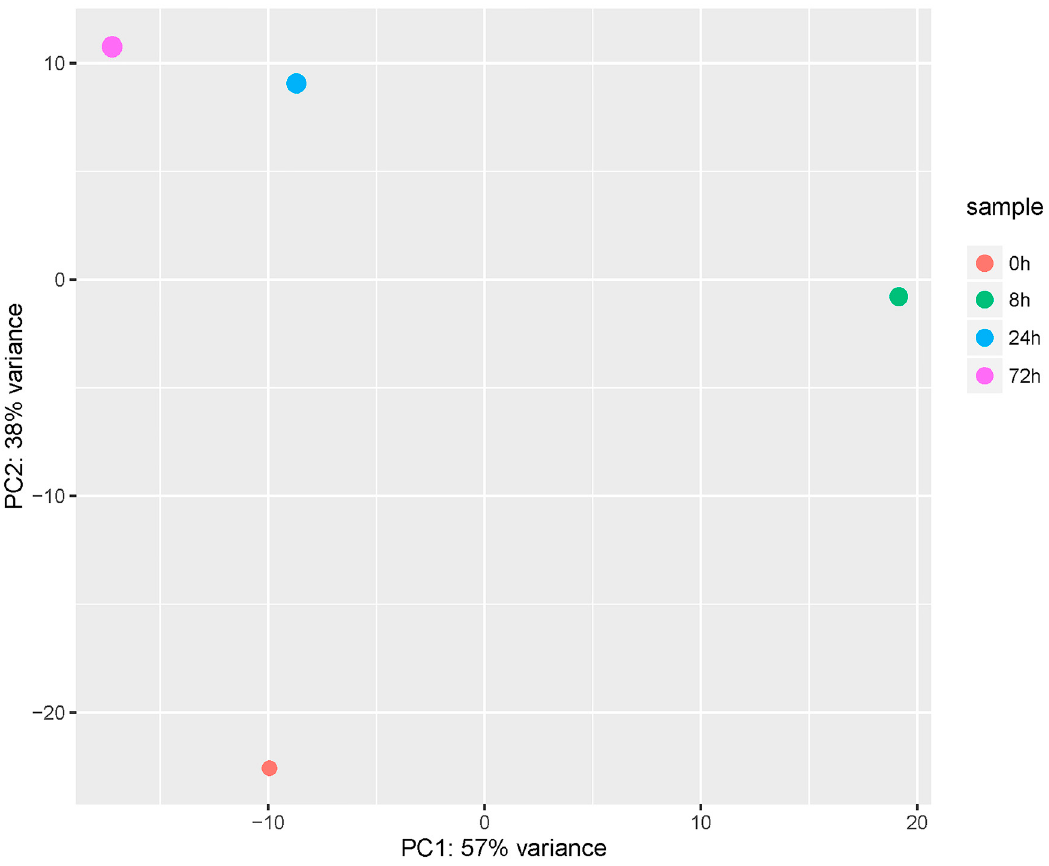
Figure 3. Principal Component Analysis. The PC1 indicates the differences among infected samples, whereas PC2 shows differences between control and infected samples.